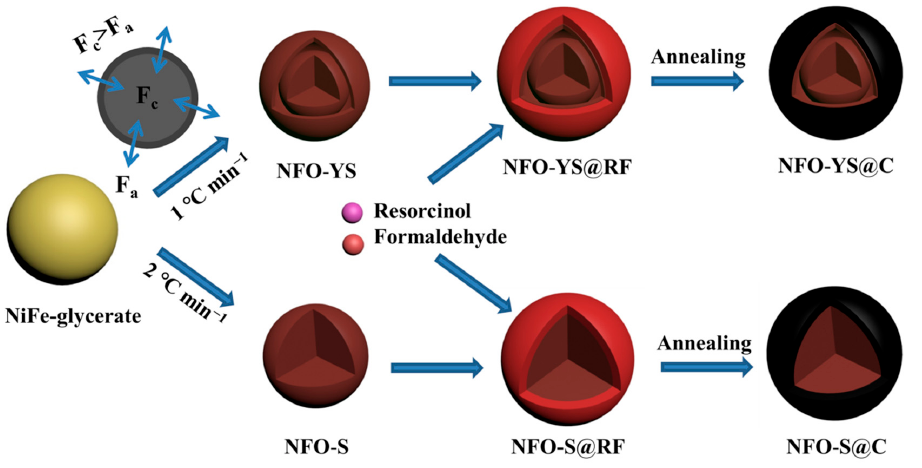
Figure 1. Schematic illustration of the formation process of NFO-YS@C and NFO-S@C.